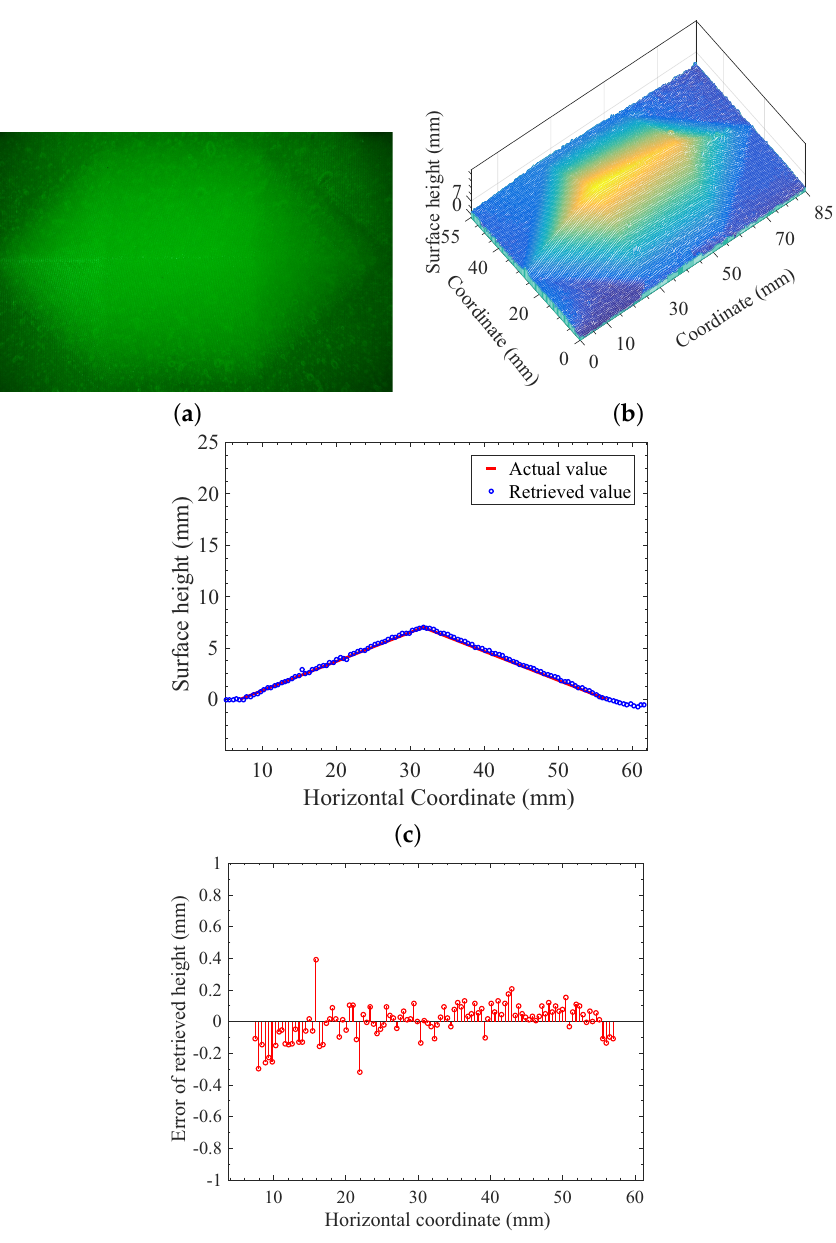
Figure 8. Measurement and reconstruction of the heptahedron-shape vulcanized silicone rubber illuminated by monochromatic sinusoidal fringe pattern at 532 nm under background illuminance E = 202 Lux. ( a ) Image of the illuminated target. ( b ) Reconstruction using the measurement of ( a ). ( c ) Comparing the retrieved height distribution on the cross section perpendicular to the ridge with actual values. ( d ) The absolute-error distribution of retrieved surface height in accordance with ( c ). The comparison of the retrieved height distribution on the cross section perpendicular to the ridge with actual values was described in the plot of Figure 8c, and the absolute- error distribution of retrieved surface height in accordance with Figure 8c is given in Figure 8d. The accuracy of reconstruction can be obtained using the comparison between the retrieved height distribution on the cross section perpendicular to the ridge and the actual geometrical parameters of the target being observed. We should point out that the individual point of largest deviation in Figure 8d was due to the little hump or hole